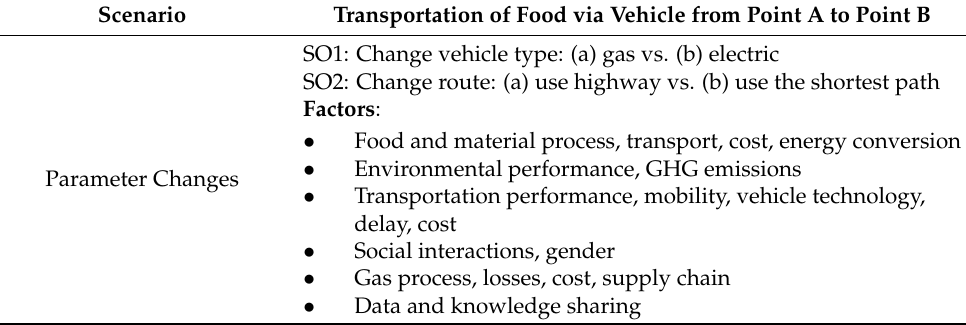
Table 4. Scenario details applied to the case study.